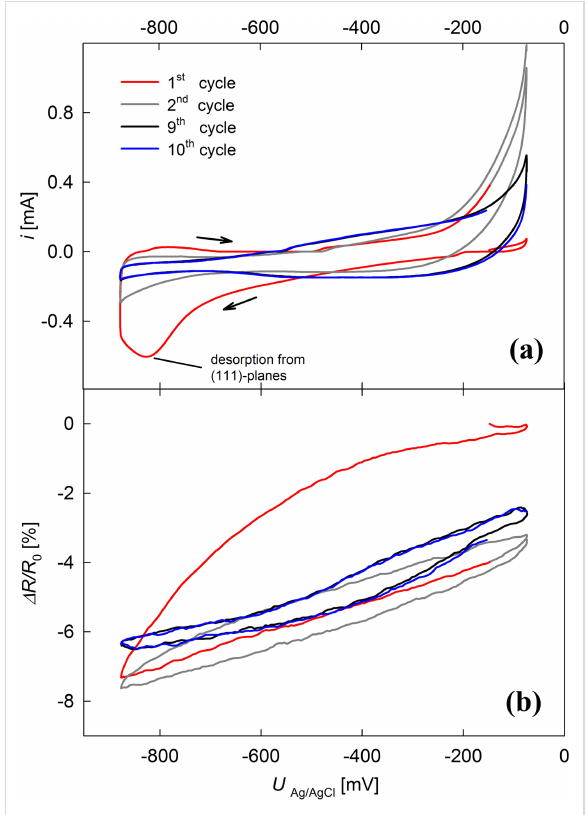
Figure 3: Cyclic voltammetry of sample B modified with cysteine (a) and concomitantly measured change in relative electrical resistance (b). The potential was varied between − 900 and − 50 mV with a scan rate of 1 mV/s in 1 M KOH.